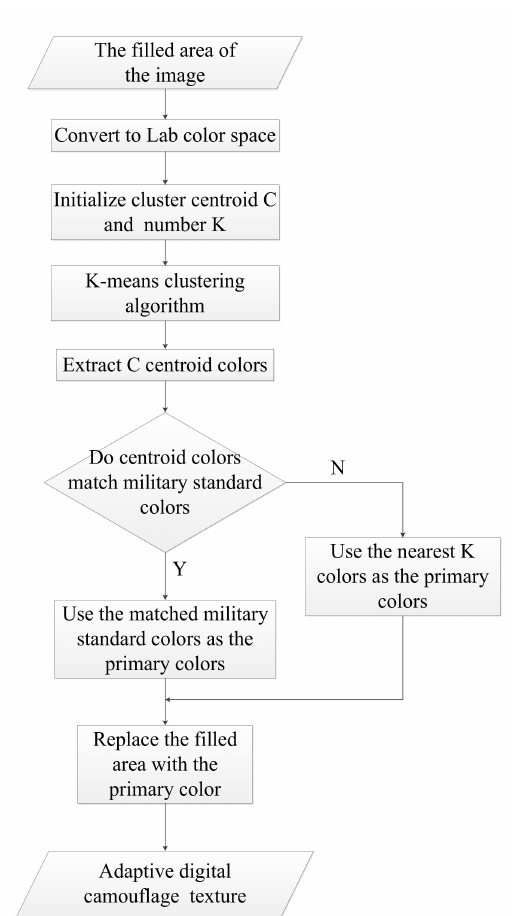
Figure 6. Standardization of camouflage texture4